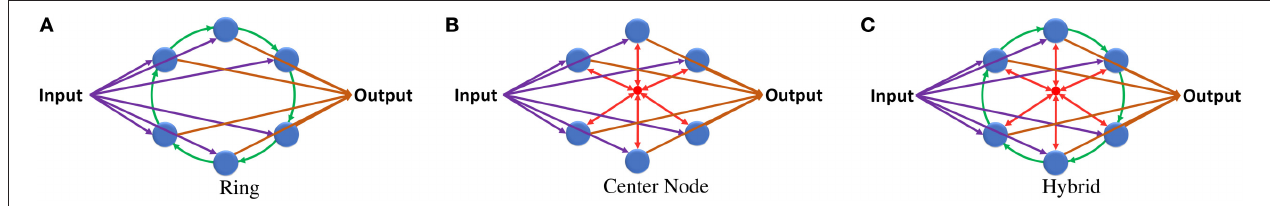
FIGURE 2 | (A) ESN with ring reservoir topology. Each reservoir neuron has two inputs and one output. (B) ESN with center neuron topology. Reservoir neurons are connected to one center neuron that works as a hub. (C) ESN with hybrid topology. Each neuron has three inputs and one output.